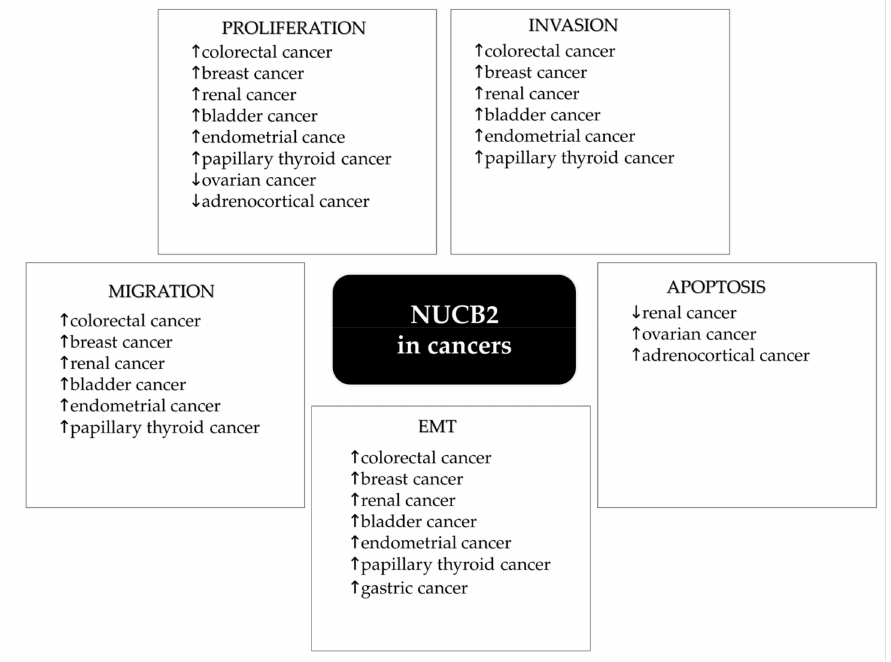
Figure 2. Role of NUCB2/NESF-1 in human tumor